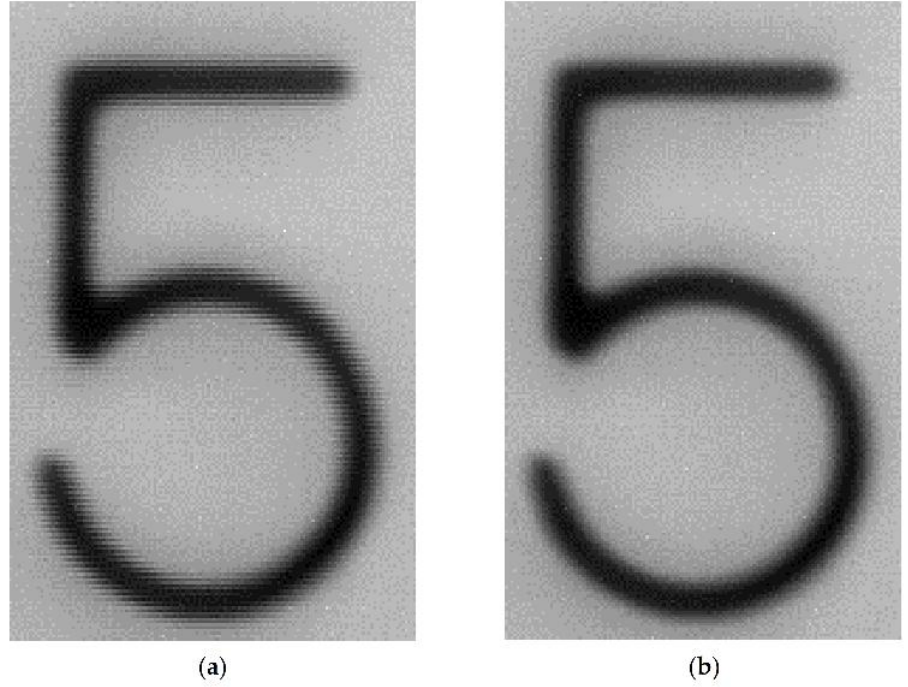
Figure 20. ( a ) Detail of an image with undesired line clutter.; ( b ) Detail of an image correctly synchro-